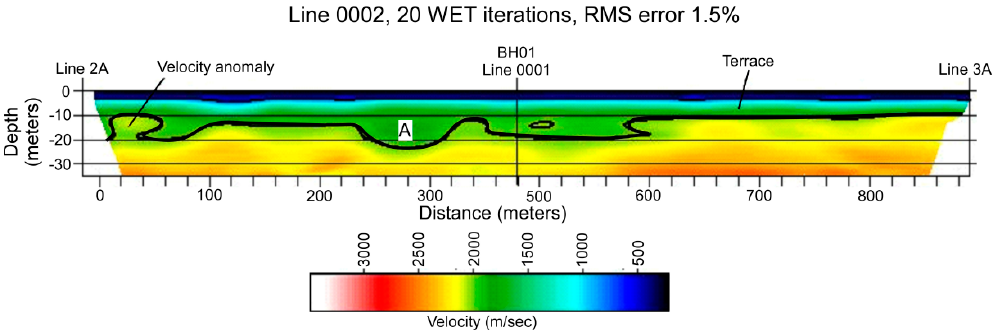
Figure 9. East-West seismic velocity profile of Line 0002, which runs through the central part of the study area. West is to the left. The terrace is indicated, as it the deepest part of the channel (indicated by A). The velocity profile at the west end of the profile also is noted.